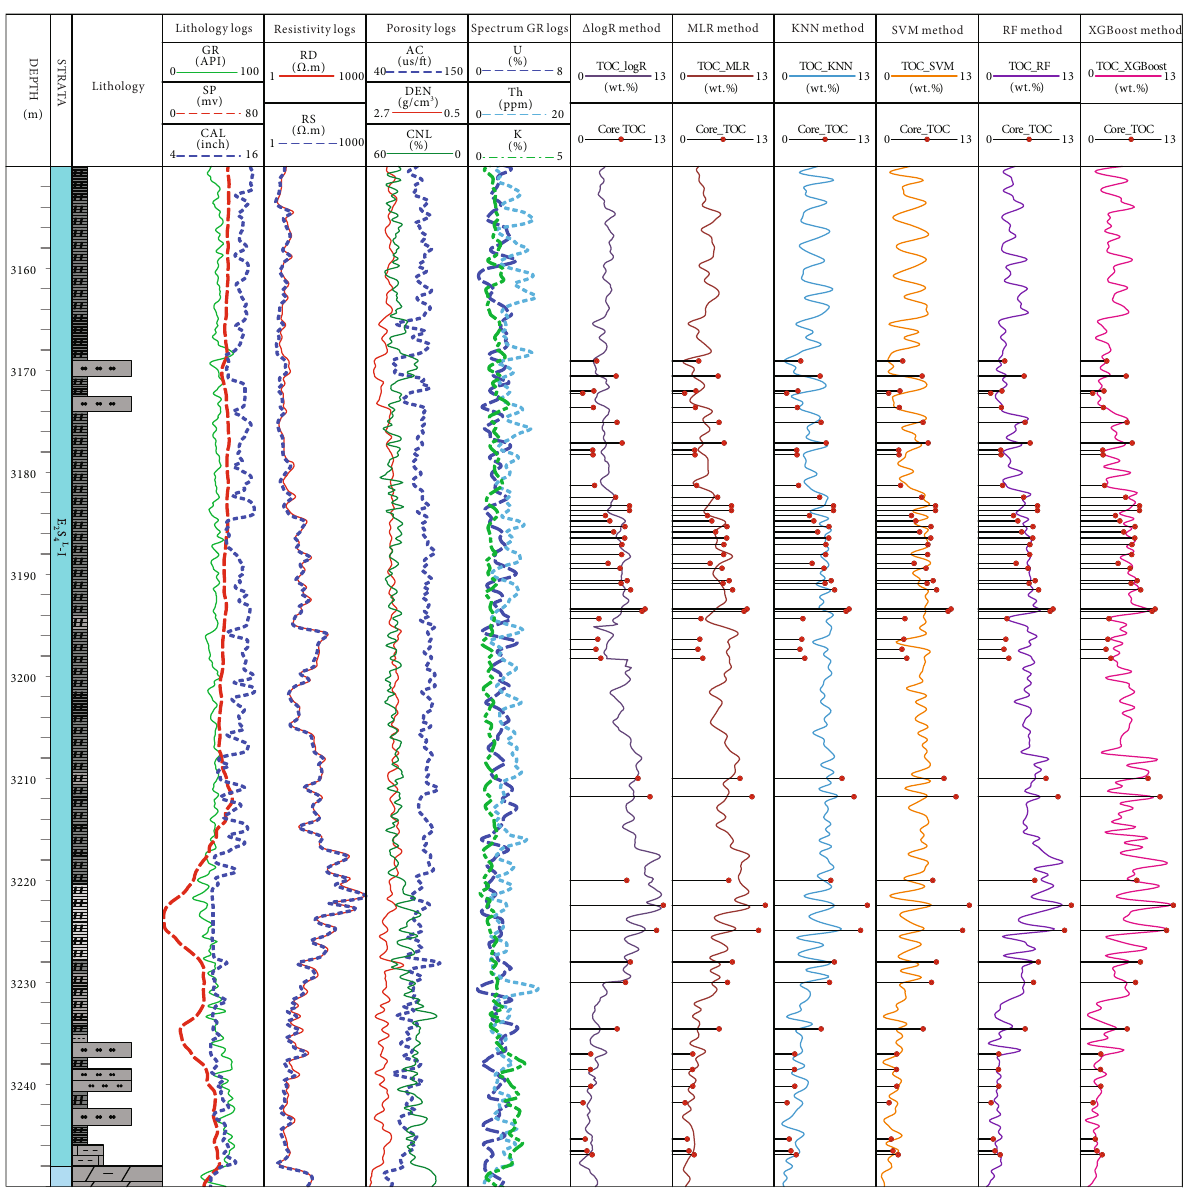
Figure 10: Comparison of prediction results by di ff erent methods (E